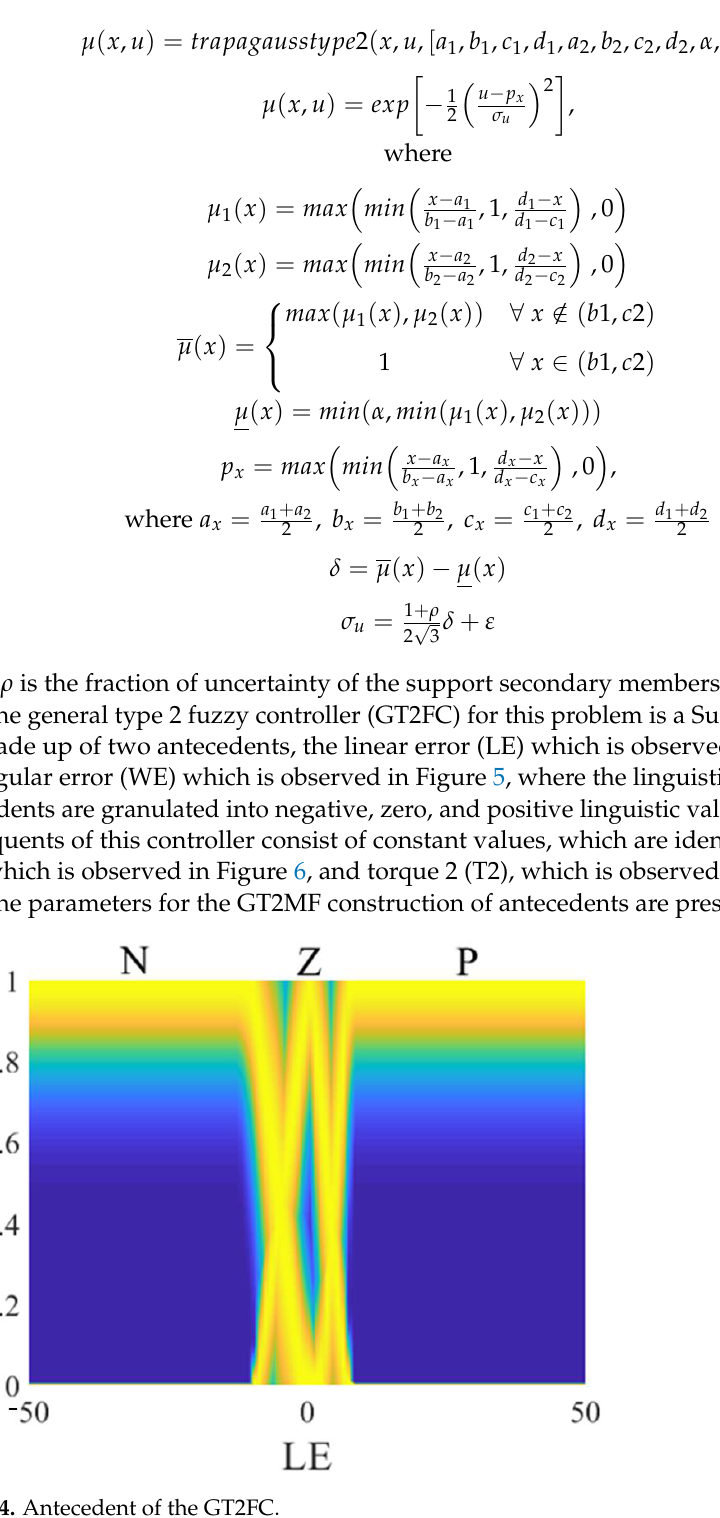
Figure 5. Antecedent of the GT2FC. The parameters for the GT2MF construction of antecedents are presented in Table 2. Table 2. GT2MF antecedent parameters.